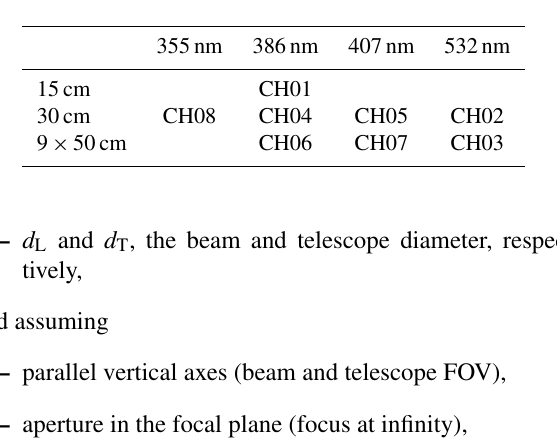
Table 4. Wavelengths and telescopes used for each currently imple- mented channel.